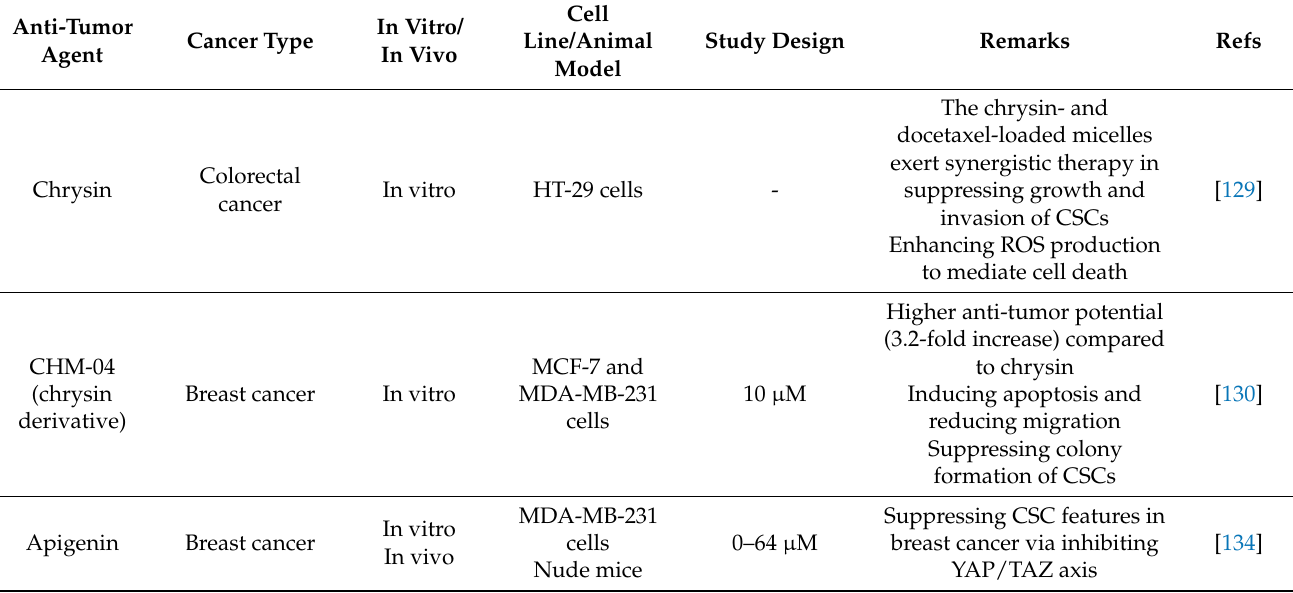
Figure 1. The potential of flavones in suppressing CSCs. Abbreviations: CSCs, cancer stem cells; NF- κ B, nuclear factor- kappaB; CDK, cyclin-dependent kinase; Oct4, octamer-4; YAP, Yes-associated protein, SOX2, sex determining region Y-box 2; TAZ, Transcriptional coactivator with PDZ-binding motif; CHM-04, a chrysin derivative; STAT3, signal transducer and activator of transcription 3; Akt, protein kinase-B; PI3K, phosphoinositide 3-kinase; ROS, reactive oxygen species. Table 1. Flavones in targeting CSCs for tumor suppression.